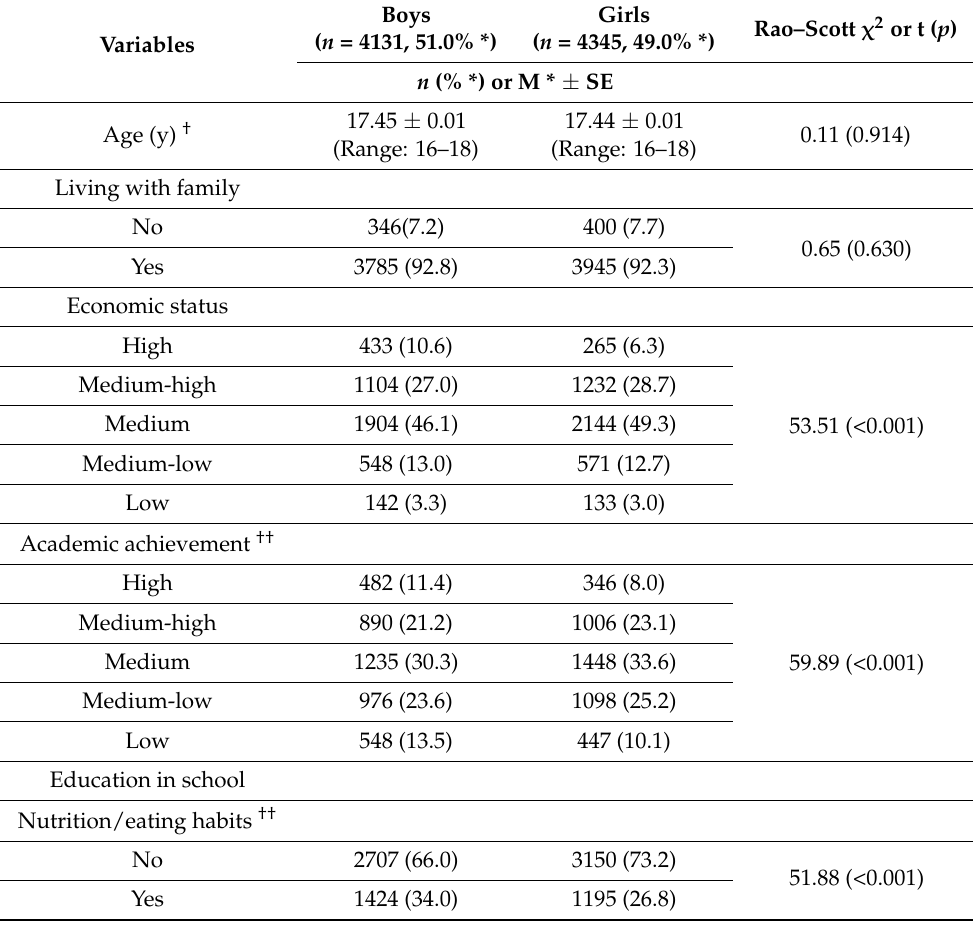
Table 1. General characteristics of the participants ( n =